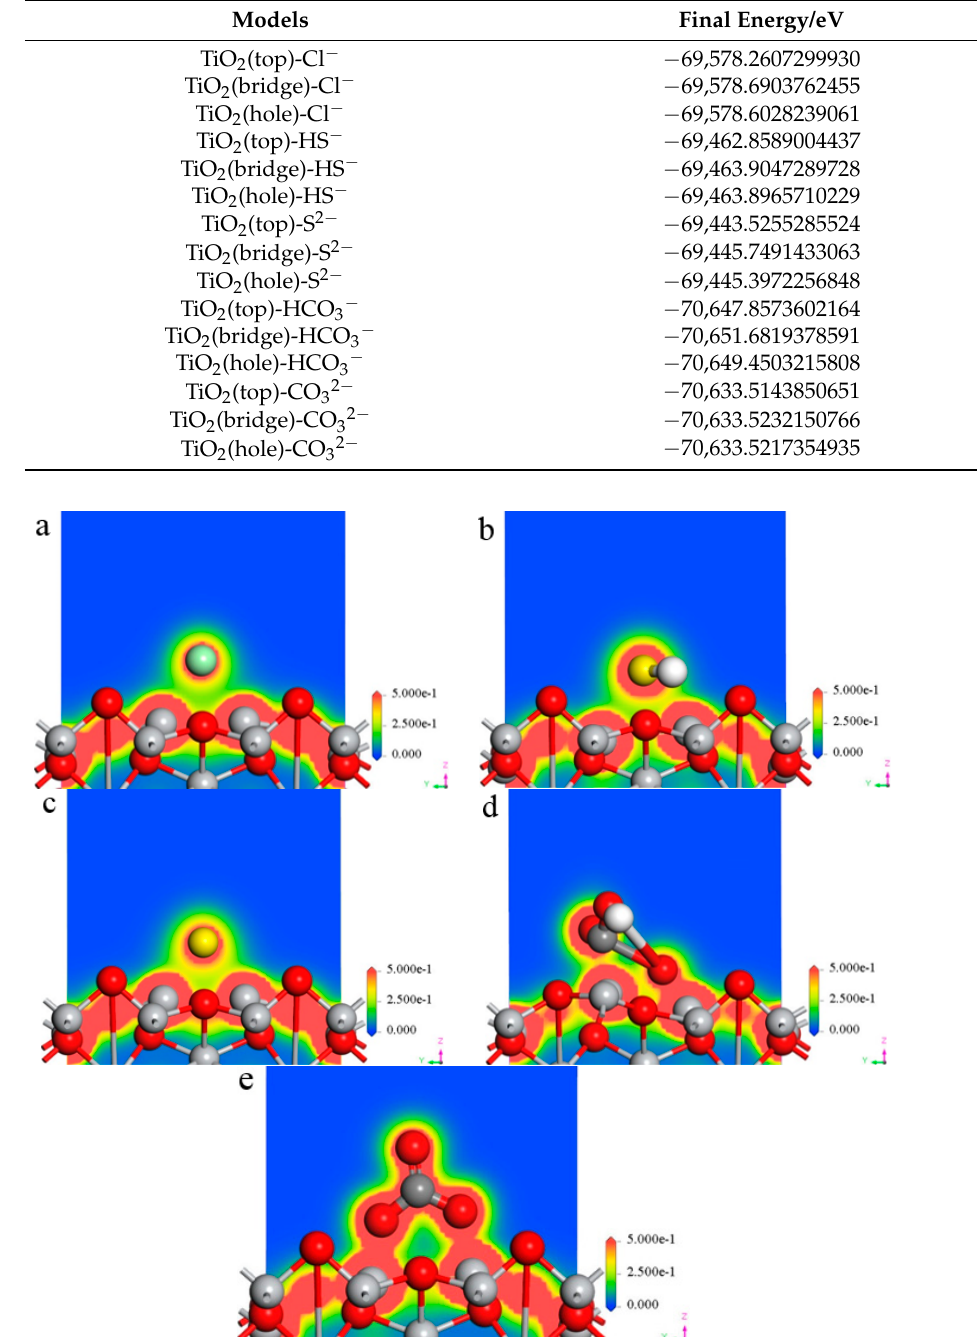
Figure 3. Charge density distribution of fi ve ions on the TiO 2 (100) surface. ( a ) Cl − ; ( b ) HS − ; ( c ) S 2 − ; ( d ) HCO 3 − ; ( e ) CO 32 − . ( d ) HCO − ; ( e ) CO 2 − 3 3